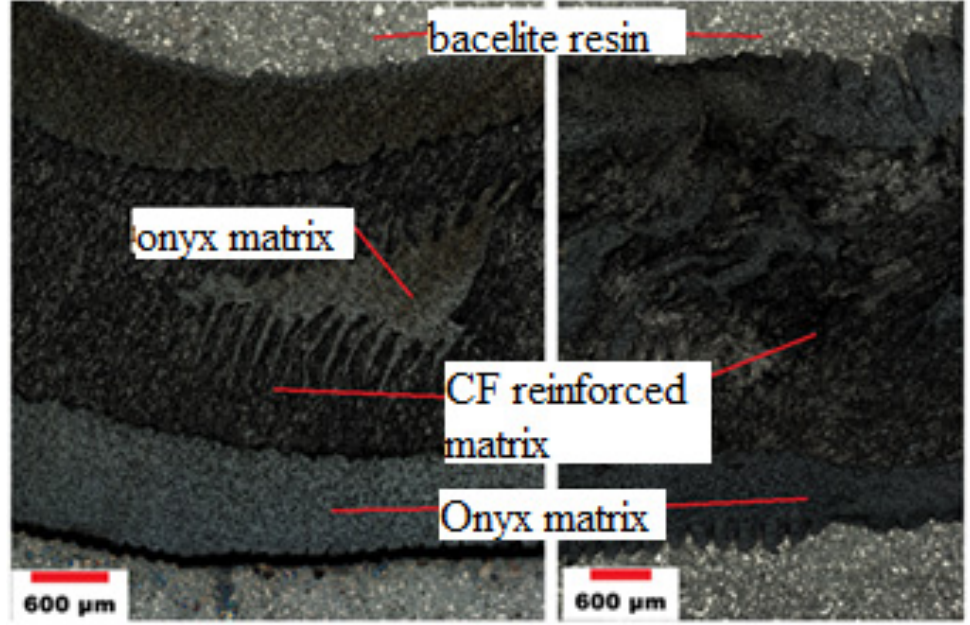
Figure 9. Optical microscopy; microstructure of CFRP/onyx produced by 3D printing. Undeformed sample ( left ), deformed sample ( right ).